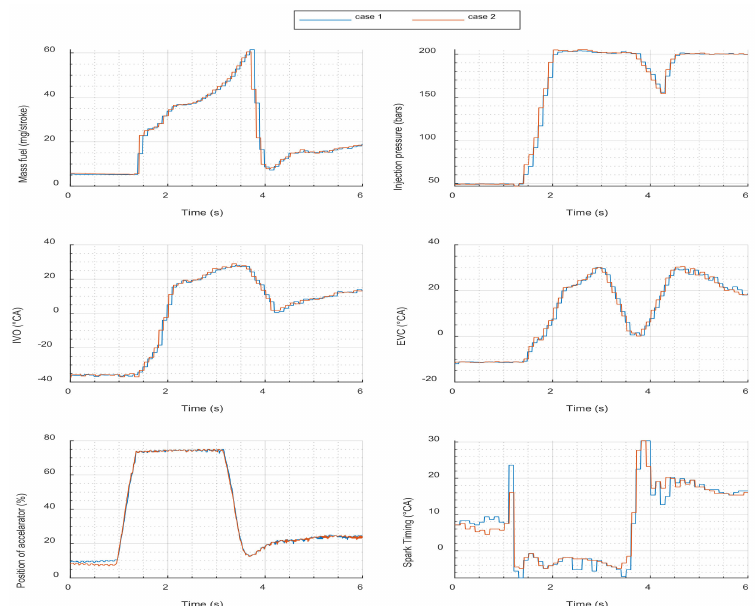
Figure 7. Motor actuators for cases 1 and